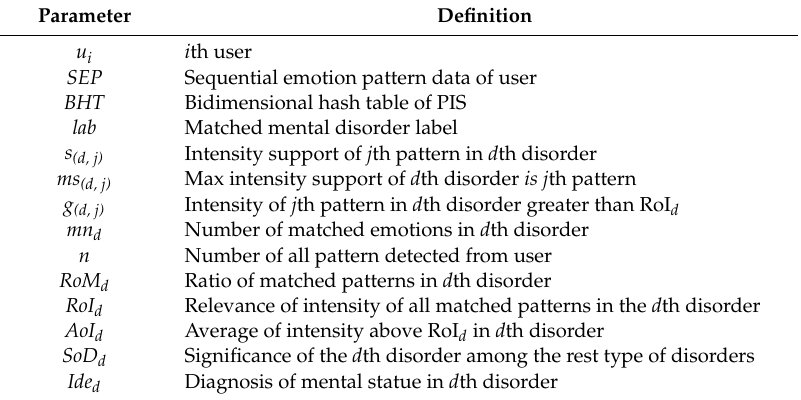
Table 3. Definition of parameters in the